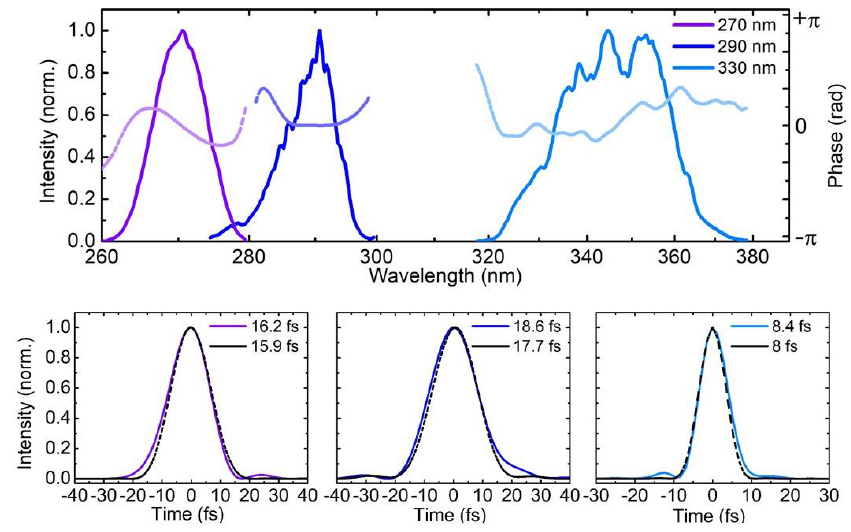
Figure 4. Upper panel: Spectra of UV pulses centered at 270 nm, 290 nm and 345 nm and corresponding spectral phases obtained using the modified 2DSI technique described in Section 3.2. Lower panel: corresponding retrieved pulse temporal profiles together with the TL profiles (dashed black lines).